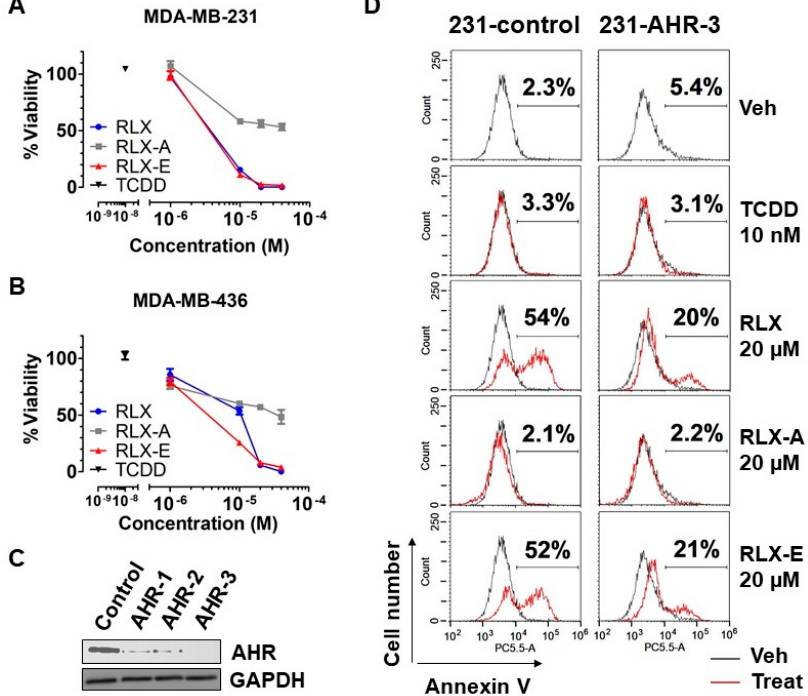
Figure 5. AhR-dependent induction of apoptosis in triple negative breast cancer (TNBC) cells. ( A , B ) Human TNBC cell lines MDA-MB-231 and MDA-MB-436 were treated as indicated for 48 h in 1%